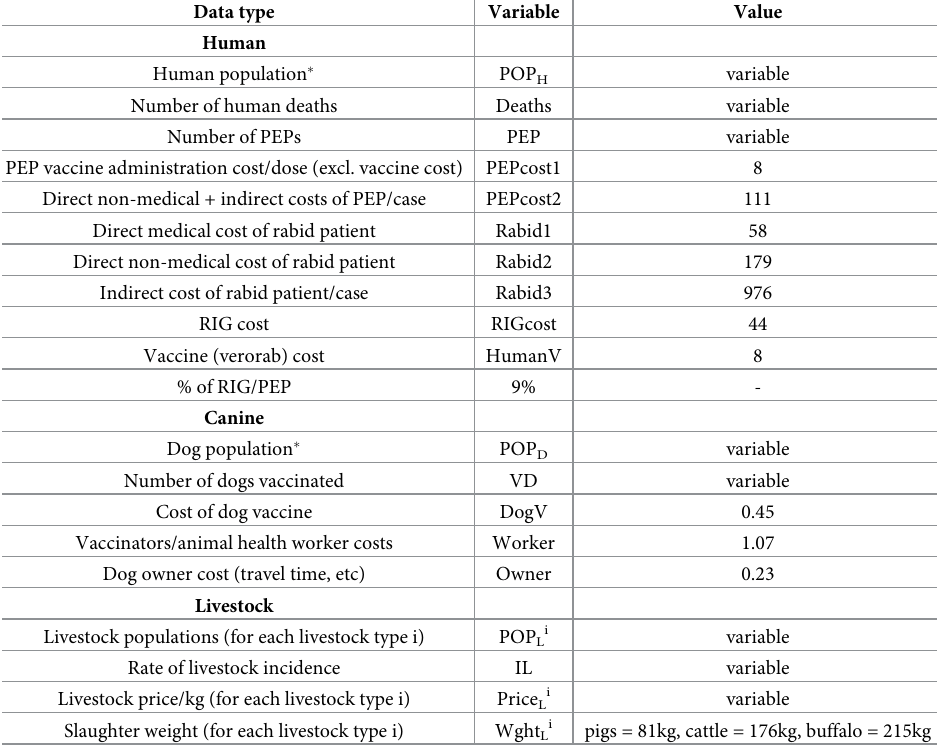
Table 5. Variable definitions, data type, and values (2017 USD) used in this